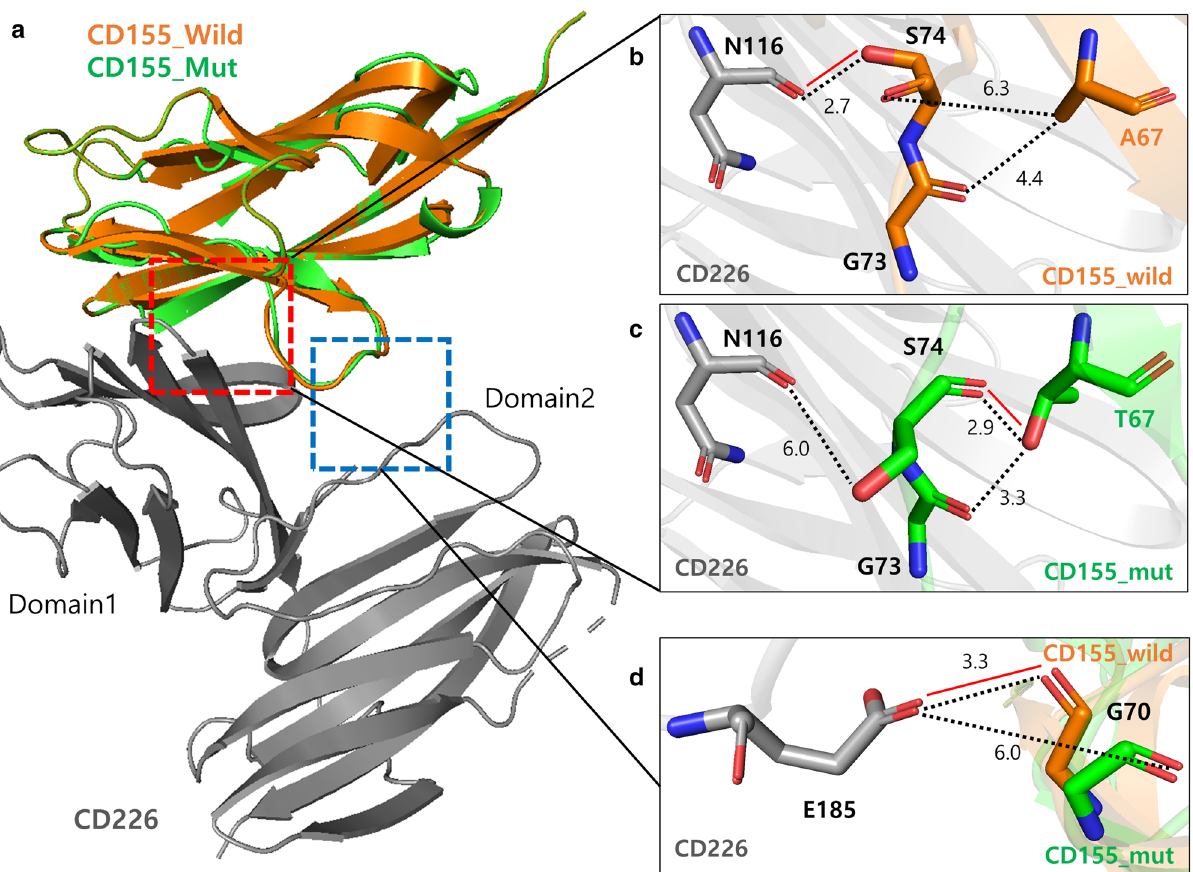
Figure 3. Structural model of CD226 / CD155 (wild-type or A67T mutant) complex. ( A ) 3-D structure of the m CD226 -ecto (Gray) and h CD155 -Domain1 (Orange) structures (PDB ID: 6ISC) aligned with the structural model of h CD155 -T67 (Green). ( B , C ) Structural detail of the interaction between CD226 -Domain1-N116 and CD155 -G73, S74, A67/T67. ( D ) Structural detail of the interaction between CD226 -Domain2-E185 and CD155 - wild-type/mutant model G70. The related amino acid residues are shown as sticks (nitrogen atoms: blue, oxygen atoms: red). Inter-atomic distance (in Angstrom) is shown as dotted black lines. The putative polar contacts are shown as red lines. All images of CD226 / CD155 (wild-type vs. A67T mutant) were made using PyMOL (https :// pymol